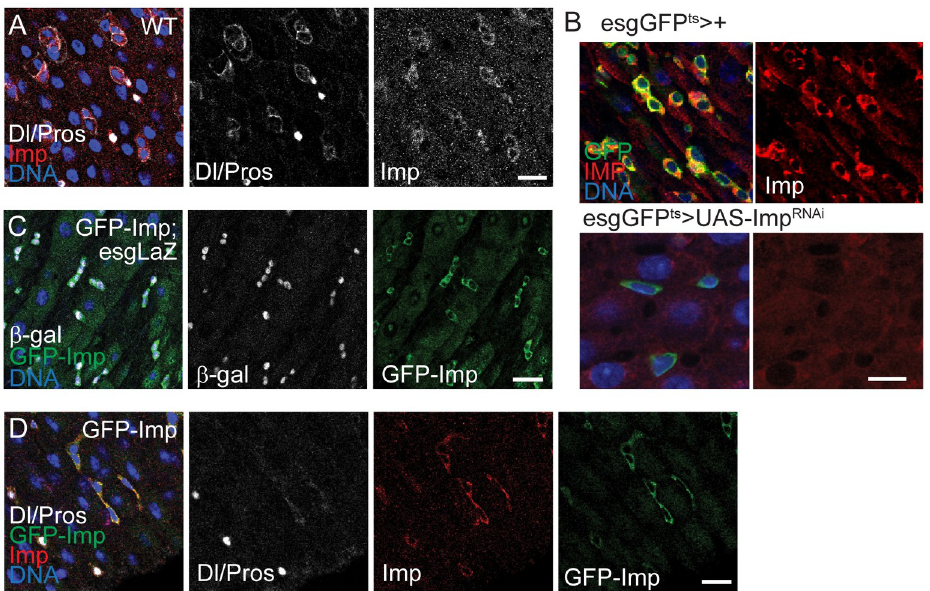
Fig 1. Imp expression in adult intestinal stem cell progenitors. (A) Confocal images of 7-day old wild type intestinal epithelium stained with antibodies specific to Imp and Delta (Dl, ISC marker) and Prospero (Pros, enteroendocrine cell marker). (B) Confocal images of 5-day old adult guts (esg-GFP ts ) stained with antibody specific to Imp shows the expression of Imp in Stem cell progenitors where GFP is expressed in ISCs and EBs. Adult specific knockdown of Imp using Imp RNAi (esg-GFP ts > ImpRNAi) leads to loss of Imp staining in the stem cell progenitors compared to controls (esgGFP ts > +). (C) Confocal images of the intestine of 7-day old trans-heterozygote for GFP-Imp-Trap and progenitor specific Lac-Z reporter (GFP-Imp;esg-LacZ) stained with antibody specific to GFP and β -galactosidase show the expression of Imp in all LacZ-positive ISCs and EBs. (D) Confocal images of 7-day old GFP-Imp gut co-stained for delta, Prospero, Imp and GFP antibody confirms the expression of Imp in ISCs and EBs. In all panels, scale bar: 10 μ